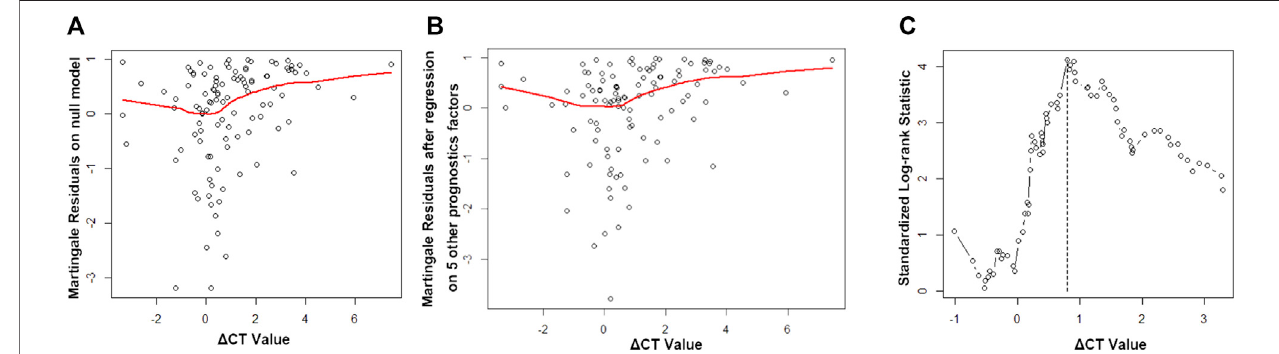
FIGURE 1 | Martingale residuals analysis and standard log-rank analysis. (A) Martingale residuals analysis of the association between the Δ CT value and progression-free survival(PFS). (B) Martingaleresidualsanalysisoftheassociationbetweenthe Δ CTvalueandPFS byage,gender,smoking status,mutationsites,and therapy line ( fi rst-line or second-line therapy). (C) Standard log-rank statistic to determine the cutoff value.